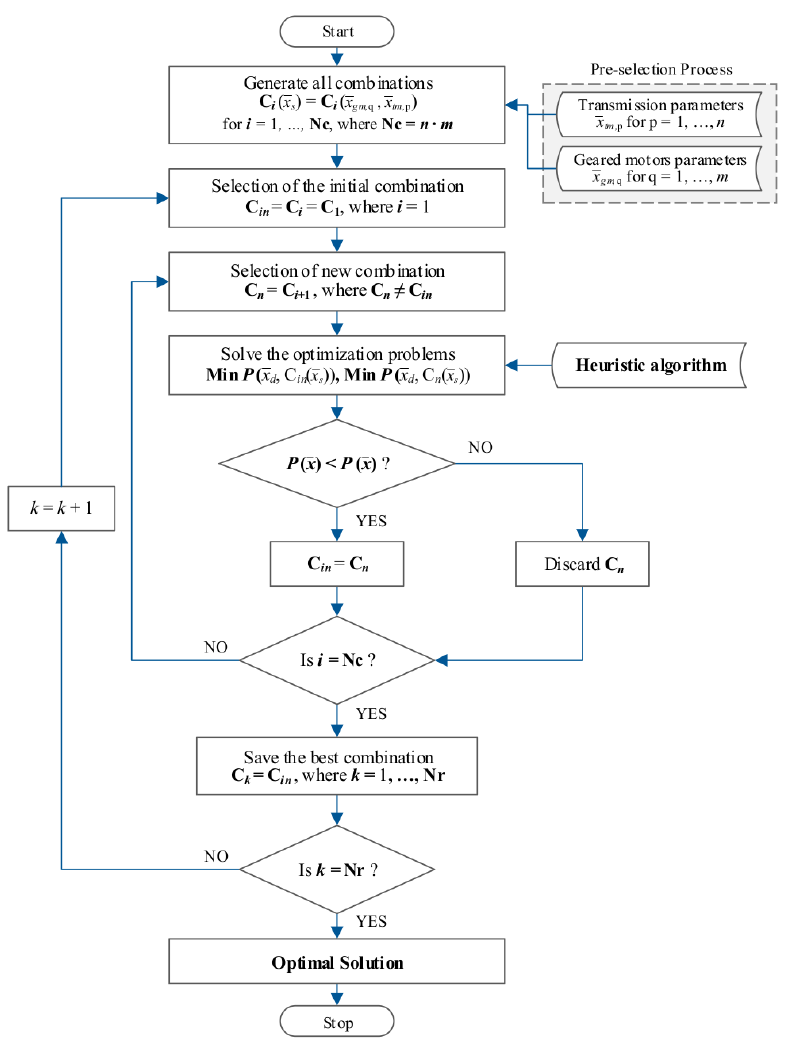
Figure 6. Flowchart of proposed algorithm for the combination problem. Table 4. Results of the design vector ¯ x d , τ 2 [Nm], and σ T [MPa] of the ten best